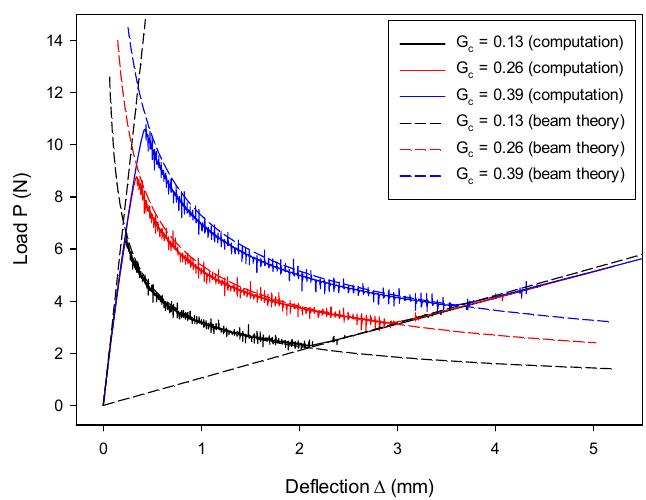
Figure 11. Load–deflection ( P ∼ ∆ ) histories vary as a function of critical energy release rate G Ic .